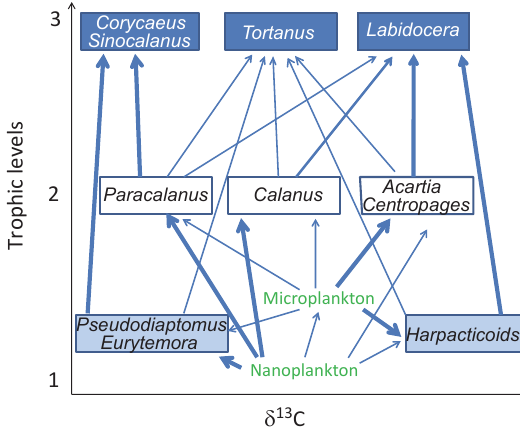
Figure 9. A simplified energy flow figure of Gwangyang Bay plank- ton and copepods. Arrows indicate feeding relationships. Thick ar- rows indicate feeding